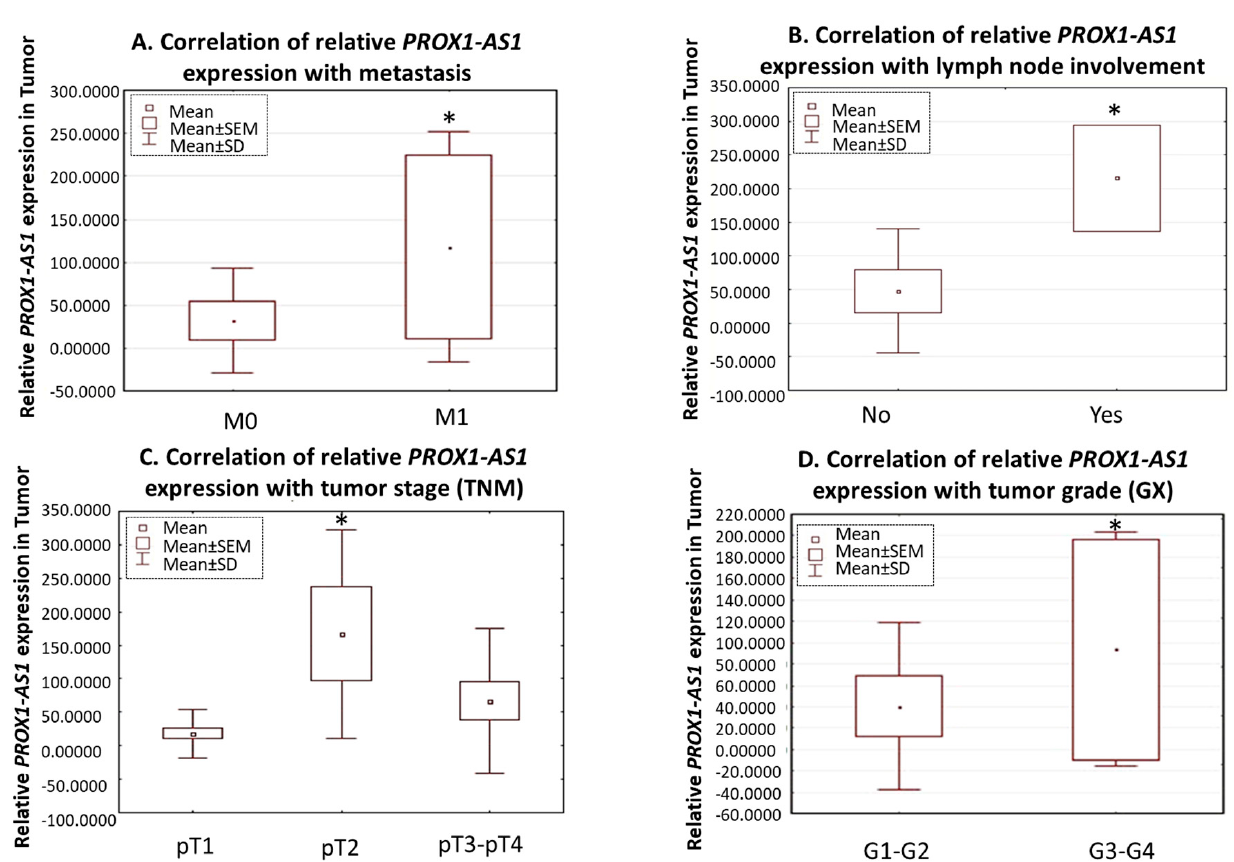
Figure 2. Expression of PROX1-AS1 in human renal cell carcinomas. ( A ) PROX1-AS1 expression is higher in patients with metastases (M1) compared to patients without metastasis (M0). ( B ) Increased PROX1-AS1 expression corresponded to lymph node tumor infiltration. ( C ) PROX1-AS1 increased in the higher tumor stages (pT1 vs. pT2 and pT3–4). ( D ) PROX1-AS1 significantly increased in G3–G4 vs. G1–G2 grades in clear renal cell carcinomas. * p < 0.05.